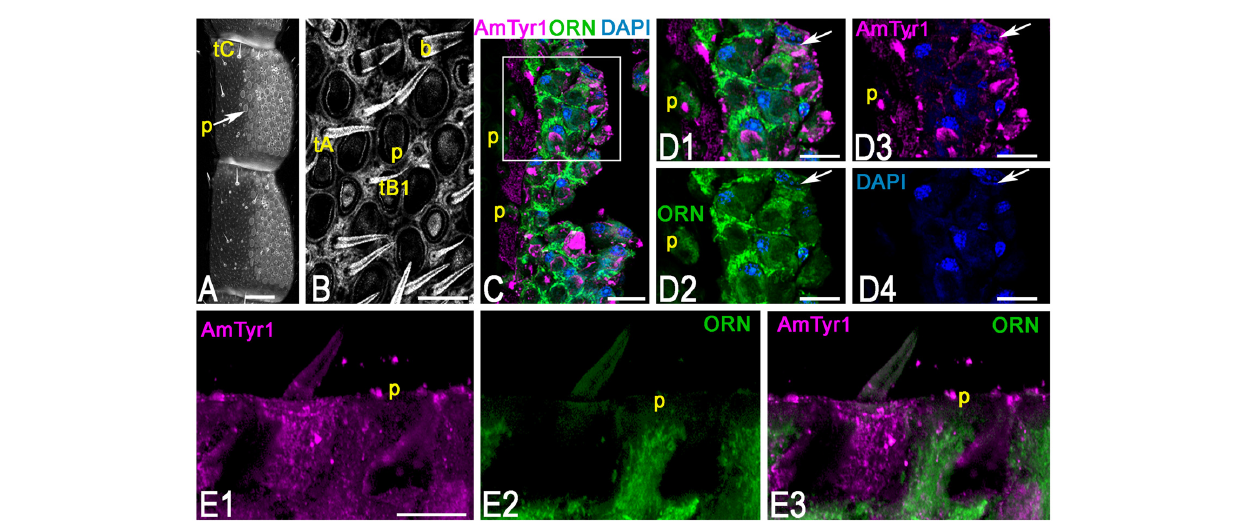
FIGURE 6 | Anti-AmTyr1 immunostaining in the antennal nerve. (A) General view of the antennal segments 5 and 6, neurobiotin was injected in the antennal lobe, and the image was obtained by overexposure with the confocal gain to illustrate different types of sensilla (tC–tricoid sensilla type C; Arrow indicates sensilla placodea (p). (B) Details of the ventral area of the antenna at higher magnification (tA, tB1, tricoid sensilla type A and B1 respectively, b-basiconic sensilla). (C) The section via antenna illustrates merged images of the group of ORN cell bodies and various processes labeled with neurobiotin tracer (green) anti-AmTyr1 (magenta), and 4 (cid:48) ,6-diamidino-2-pheylindole (DAPI), marking the nucleus, P-indicate the fibers in the sensilla placodea. (D) Images present higher magnifications of details from corresonding squares indicated in (C) . (D1) shows of cell bodies and processes labeled with neurobiotin (green) and anti-AmTyr1 staining (magenta, single staining) and nuclei (blue, DAPI). (D2) illustrates only neurobiotin labeled processes (green) and nuclei (DAPI, blue). (D3) illustrates only anti-AmTyr1 (magenta) and nuclei (DAPI). (D4) shows the nuclei staining. The arrow indicates cell bodies that have co-staining with AmTyr1 and neurobiotin. (E) Anti-AmTyr1 ( E1 single image, magenta) is in the area of sensilla placodea (p) with dendrites of ORNs labeled with neurobiotin (green E2 ). The absence of the white staining in merged image (E3) demonstrates that AmTyr1 does not co-label dendrites of labeled ORNs. Scale bar: A = 100 µ m; B,E = 20 µ m; C = 25 µ m; D = 10 µ